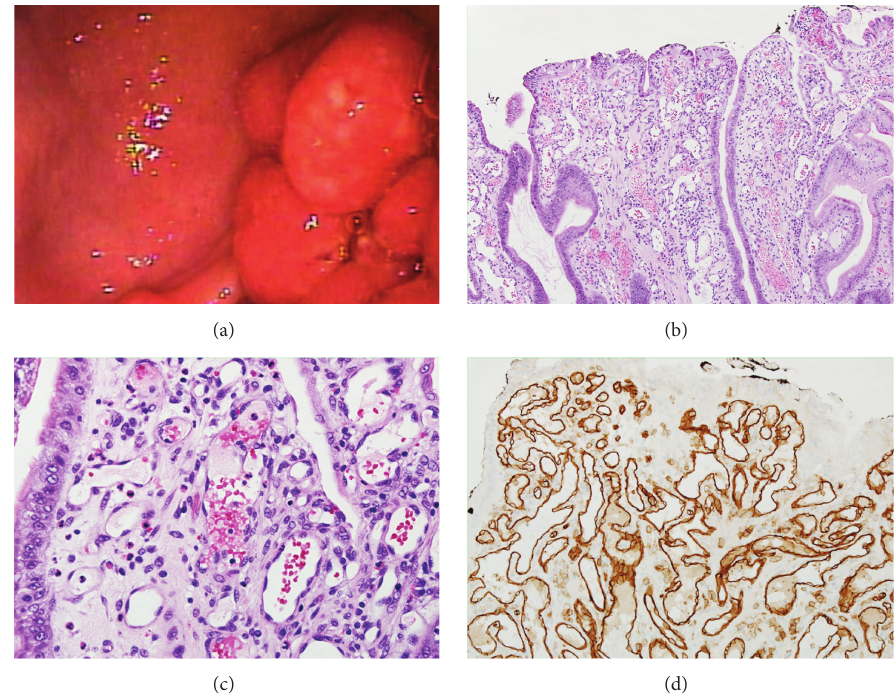
Figure1:Pyogenicgranulomaofthestomach(Case 1 ).(a)Endoscopicappearanceofthe40 mmgastricpolypoidnodulewithsurfaceerosion. (b-c) Histologically, a capillary hemangioma is present and arranged in a lobular pattern and filled with clusters of small capillary vessels ((b), × 100; (c), × 400). (d) Immunohistochemistry of CD31 highlighting the capillary proliferation ( ×